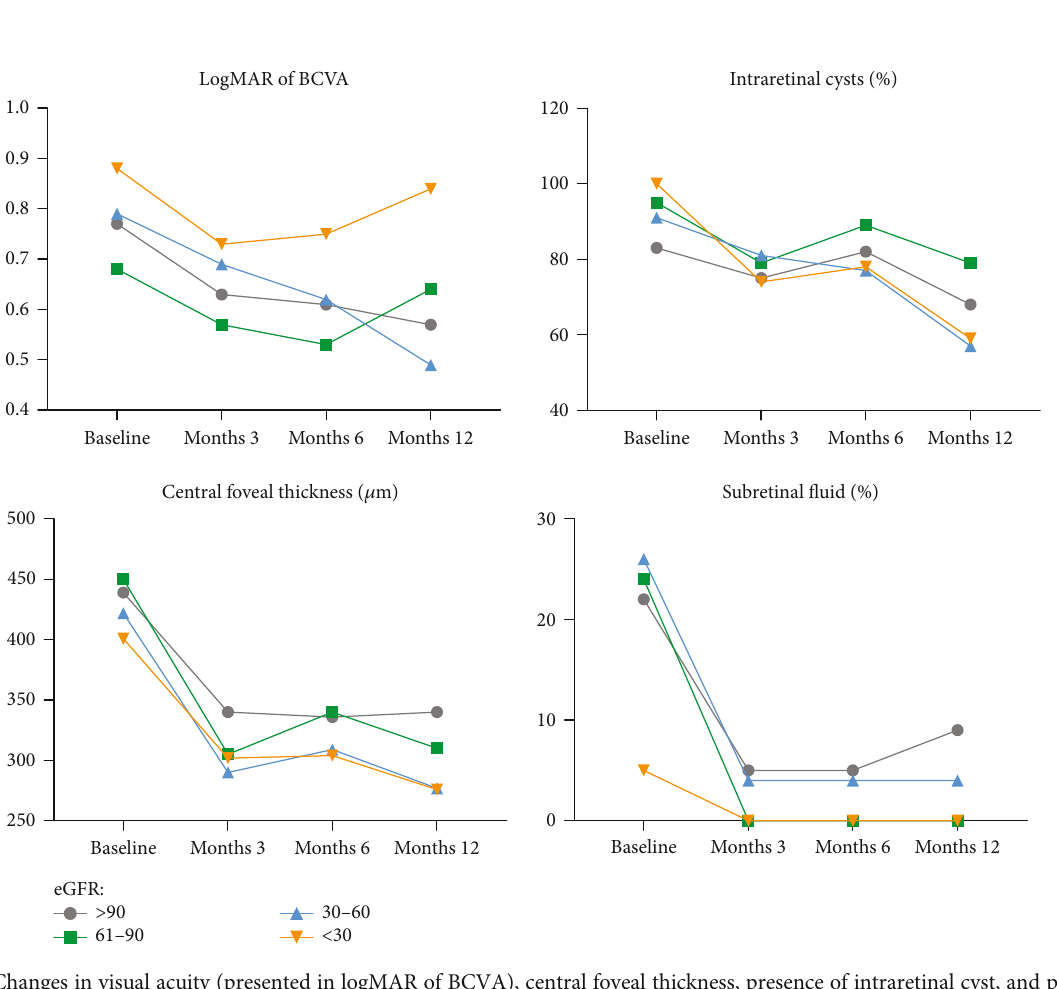
Figure 2: Changes in visual acuity (presented in logMAR of BCVA), central foveal thickness, presence of intraretinal cyst, and presence of subretinal fl uid after intravitreal ranibizumab injection for diabetic macular edema in di ff erent groups of eGFR